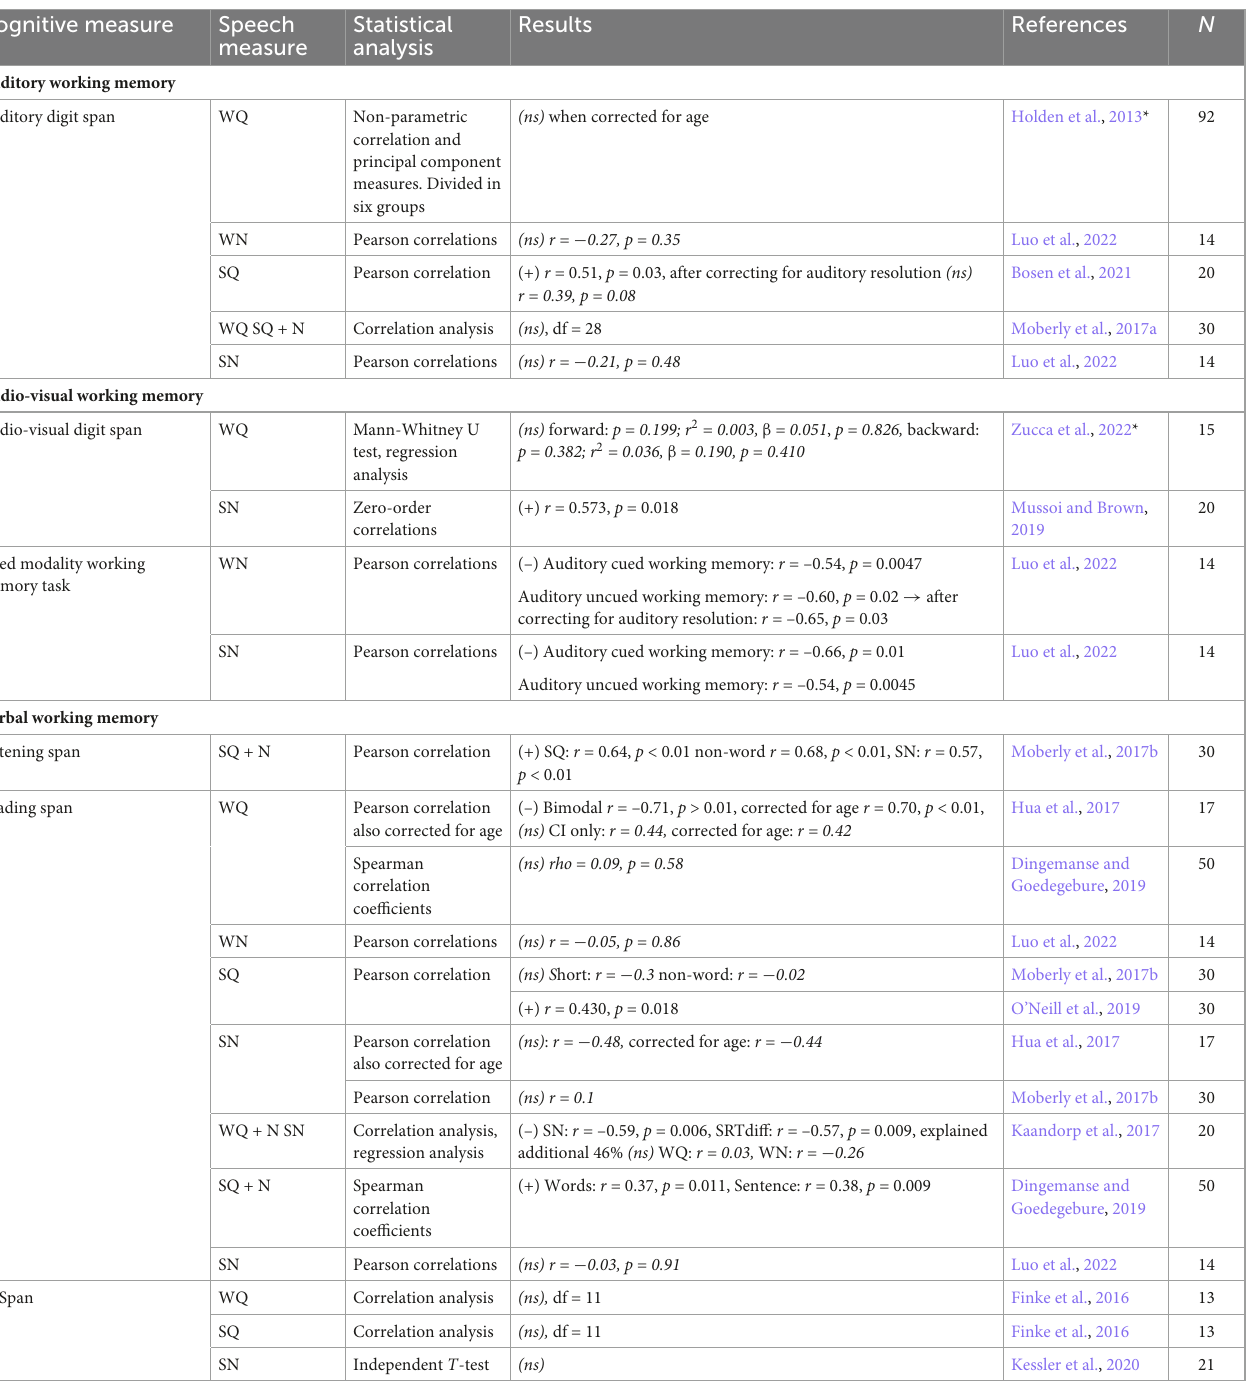
TABLE 8 Overview of included papers studying auditory, audio-visual and verbal working